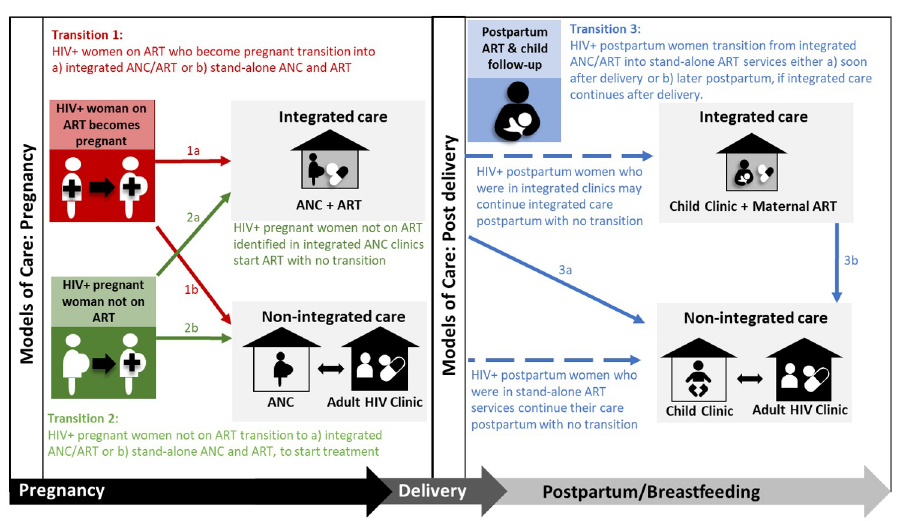
Fig 1. Points of transition into and out of PMTCT for continued ART during and after pregnancy. ART— antiretroviral therapy; ANC—antenatal care. Reprinted from Phillips TK et al., J Int AIDS Soc 2020,